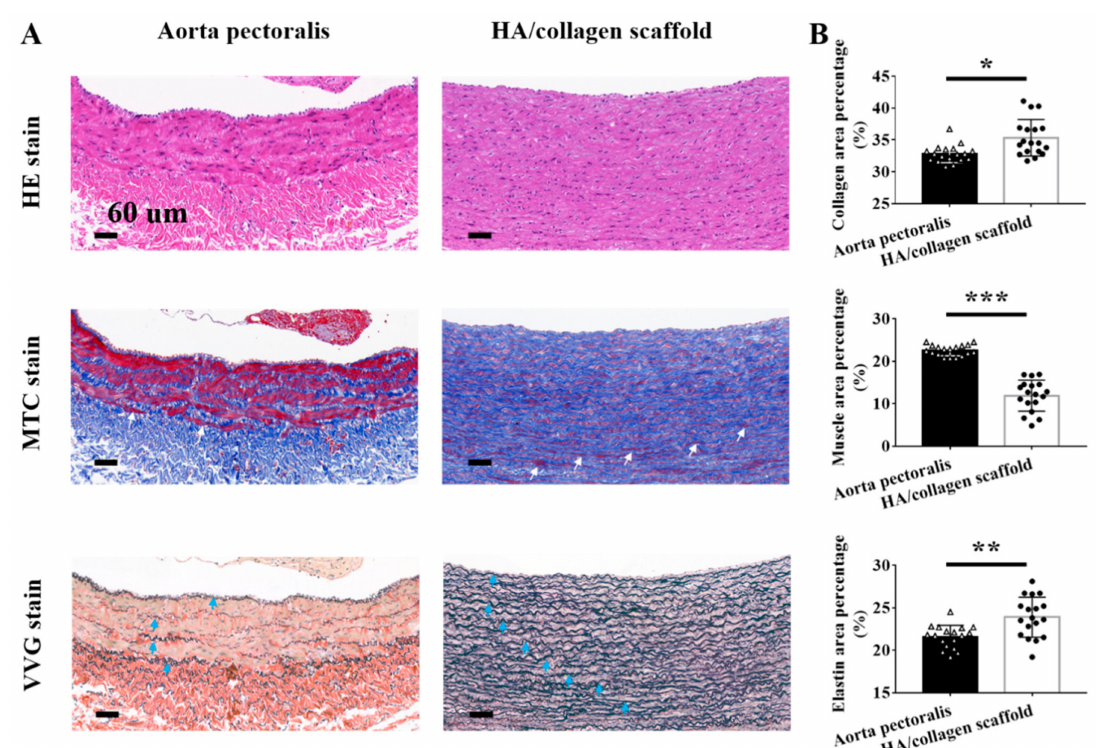
Figure 7. Histological evaluation. ( A ) Representative H&E, MTS, and VVG staining of rabbit native aorta pectoralis and cellularized tubular HA/collagen scaffold. Scale bars: 60 µ m. ( B ) Statistical data of collagen, muscle bundles and elastin of rabbit native aorta pectoralis and cellularized tubular HA/collagen scaffolds ( n = 3). * p < 0.5; ** p < 0.01; *** p < 0.001.